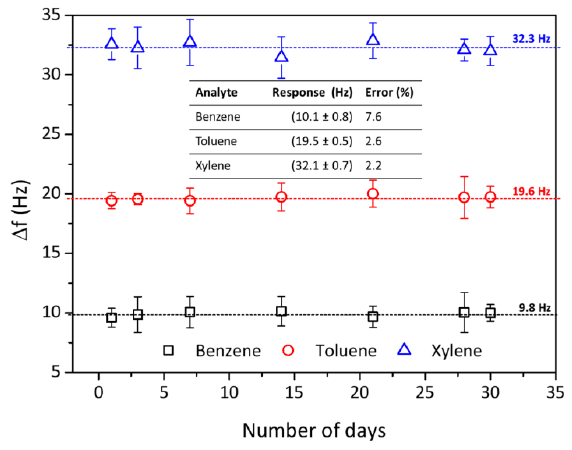
Figure 8. long-term stability of PVAc film QCM sensor exposed to 622 ppm of BTX vapors (inset: repeatability calculation of 10 repeated measurements).